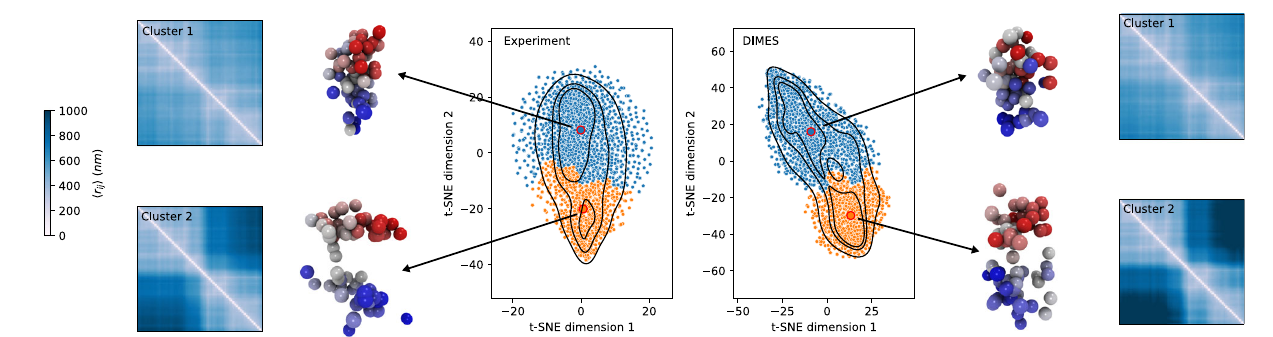
Fig.6|Phasespacestructureofthe2-MbpChr21organization. t-SNEprojections are calculated from the conformations and the agglomerative clustering results. Individualconformationisprojectedontoatwo-dimensionalmanifoldusingt-SNE. Contourlinesofthedensityoft-SNEprojectionsareshowntore fl ecttheunderlying